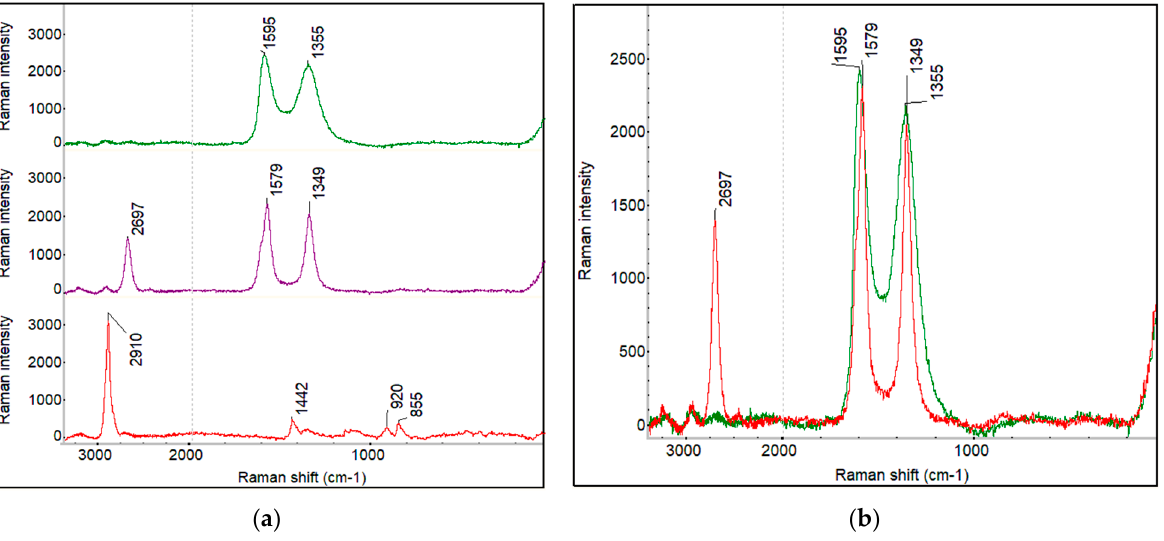
Figure 5. ( a ) Raman spectra. From top to bottom: GO powder, CNT_COOH powder, and PVA film. ( b ) Raman spectra overlay of GO powder (green) and CNT_COOH powder (red). ( b ) Raman spectra overlay of GO powder (green) and CNT_COOH powder (red). Optical and Raman Imaging of PVA Membrane Optical and Raman Imaging of PVA